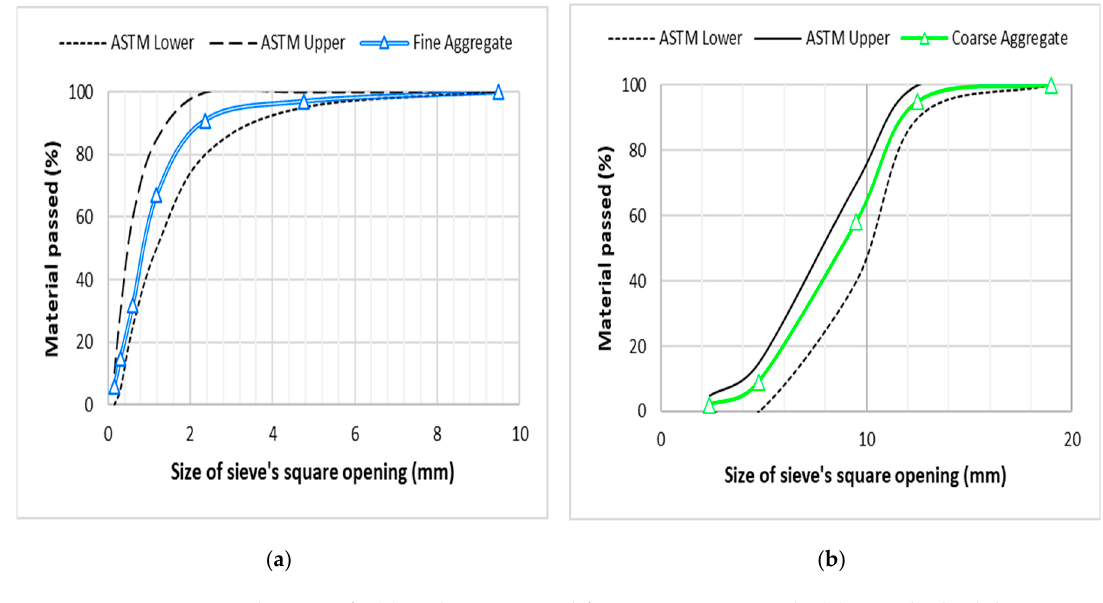
Figure 1. Gradation of ( a ) Siliceous sand / fine aggregate and ( b ) crushed dolomite limestone / coarse aggregate.